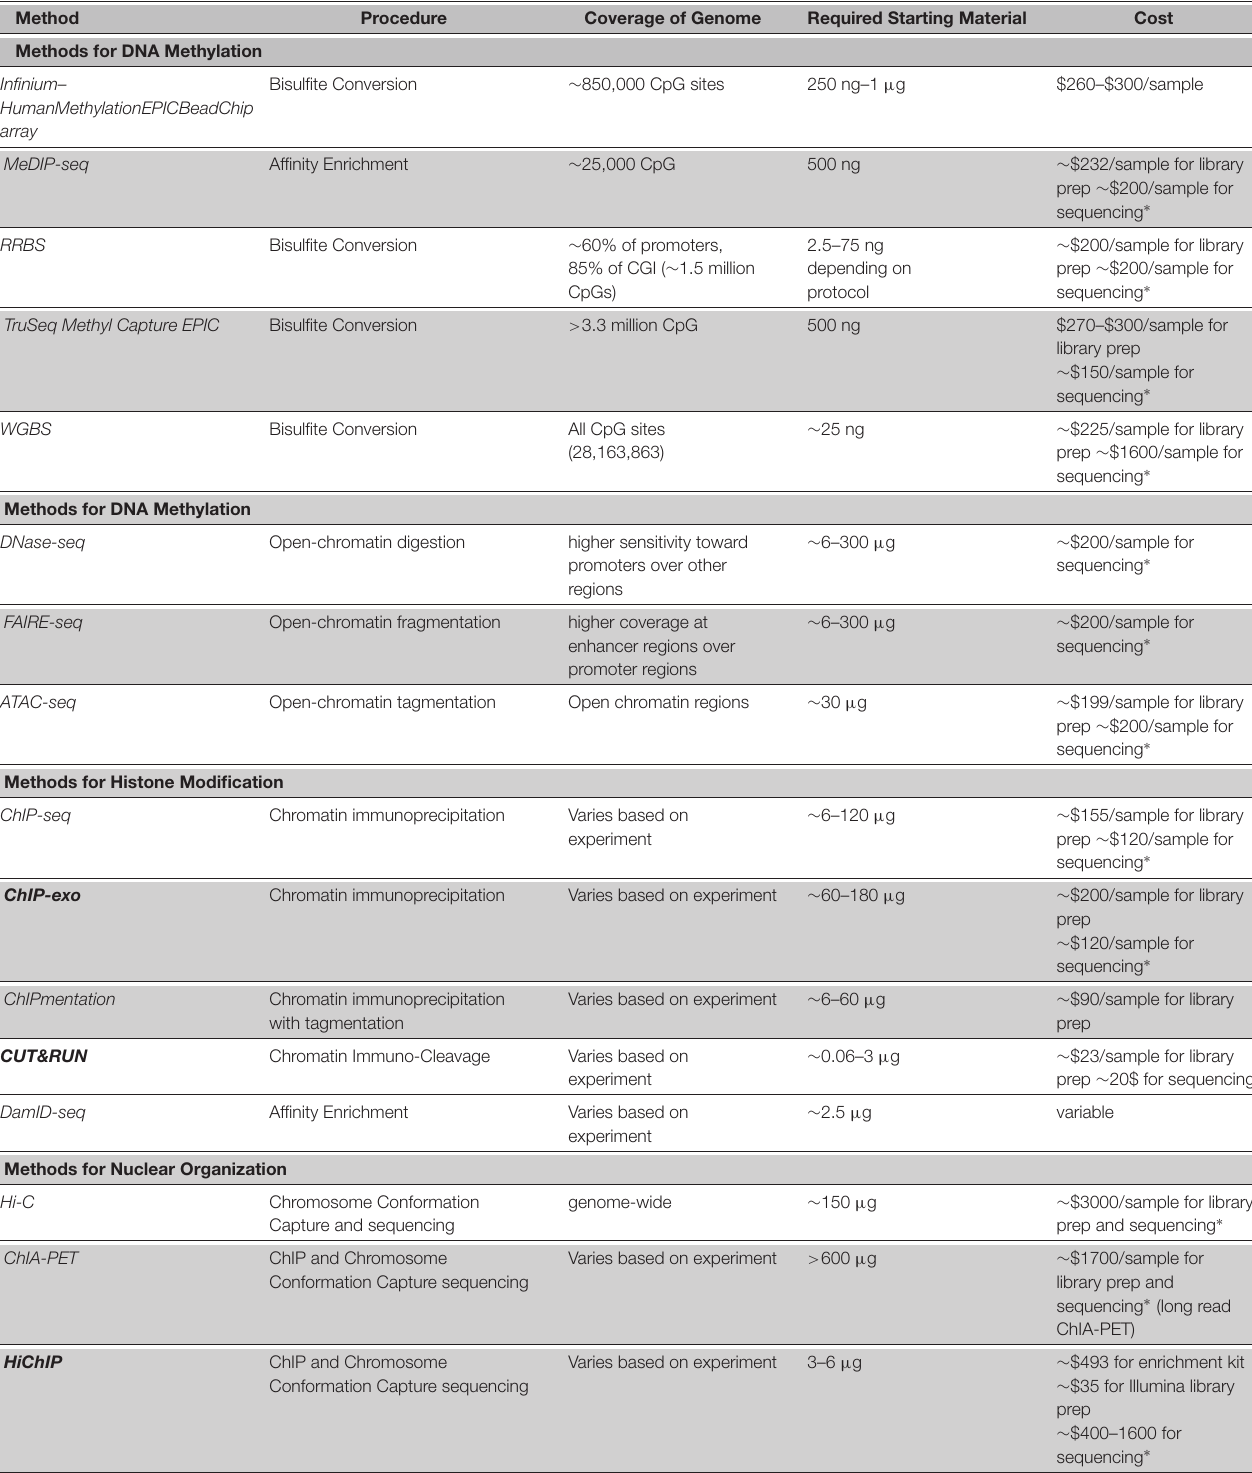
TABLE 1 | Comparison of methods for epigenome analysis on bulk